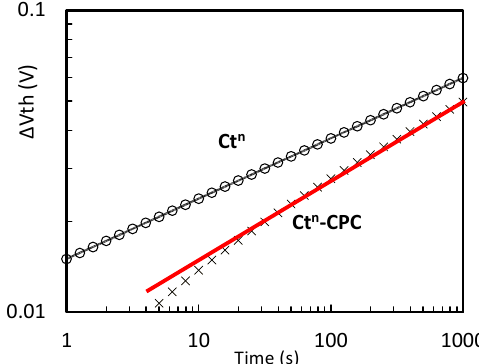
Figure 25. An illustration of the impact of a loss of CPC on the aging kinetics. Although the data after the loss (symbols “×”) can be fitted reasonably well with a power law (red line), the power exponent (i.e., the slope of the red line) is overestimated, when compared with its true value (i.e., the slope of the black line).